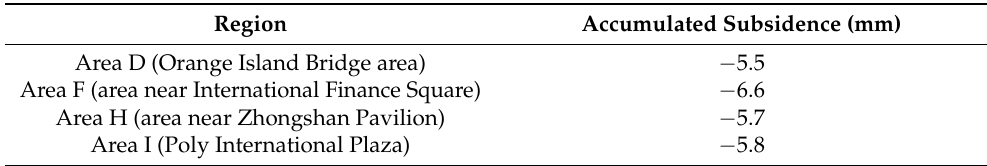
Figure 10. Enlarged deformation maps of ( a ) area D, ( b ) area H, ( c ) area F, and ( d ) area I. The maximum settlement in area D is located near the center of the bridge, while area H is located near Zhongshan Pavilion; area F is near the International Finance Square building, and area I is near Poly International Plaza. The quantitative maximum cumulative settlements are shown in Table 3. Table 3. Accumulated subsidence in typical areas.